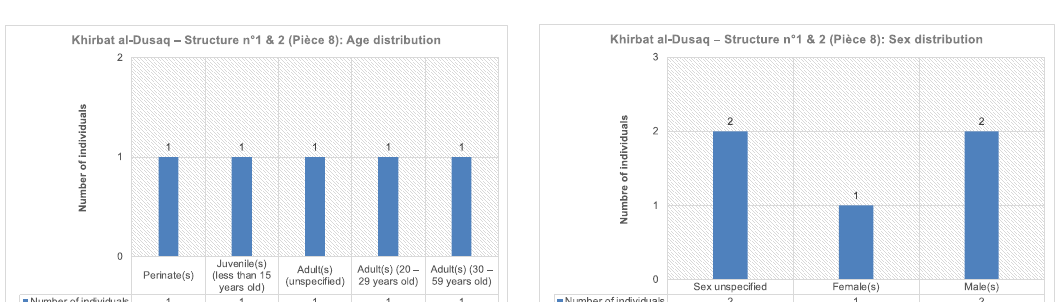
Figure 12: Structure no 1 and 2 ( Pièce 8 ) : frequency and exclusion MNI graph ( top ) , age distribution graph ( bottom left ) , and sex distribution graph ( bottom right ) . Figures by Hofstetter ( 2022 )